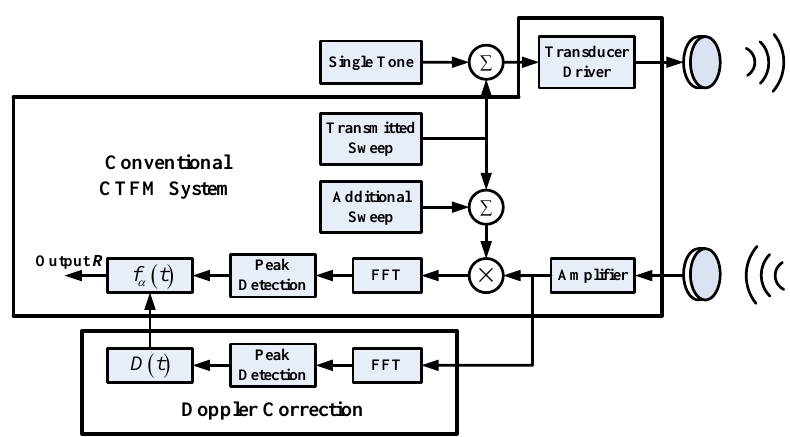
Figure 8. A block diagram of the